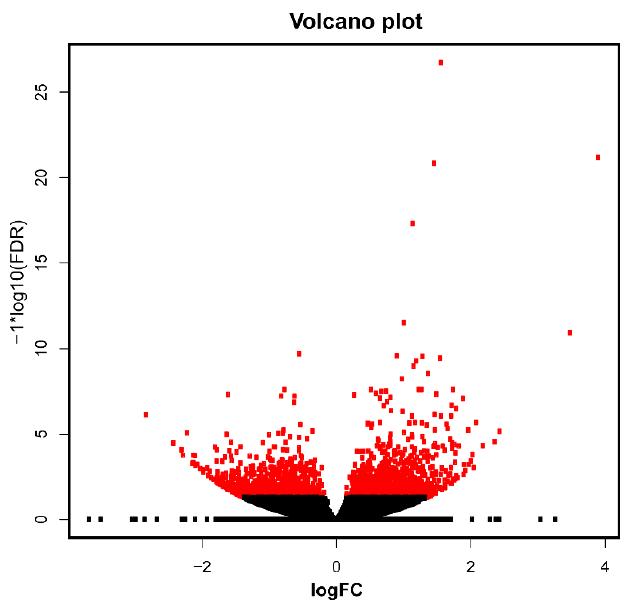
Figure 3. Volcano plot of differentially expressed genes between control (without microbial inoculation) and treatment (with microbial inoculation) conditions in Eucalyptus globulus roots transcriptome. In red, differentially expressed genes; in black, genes without variation in expression.